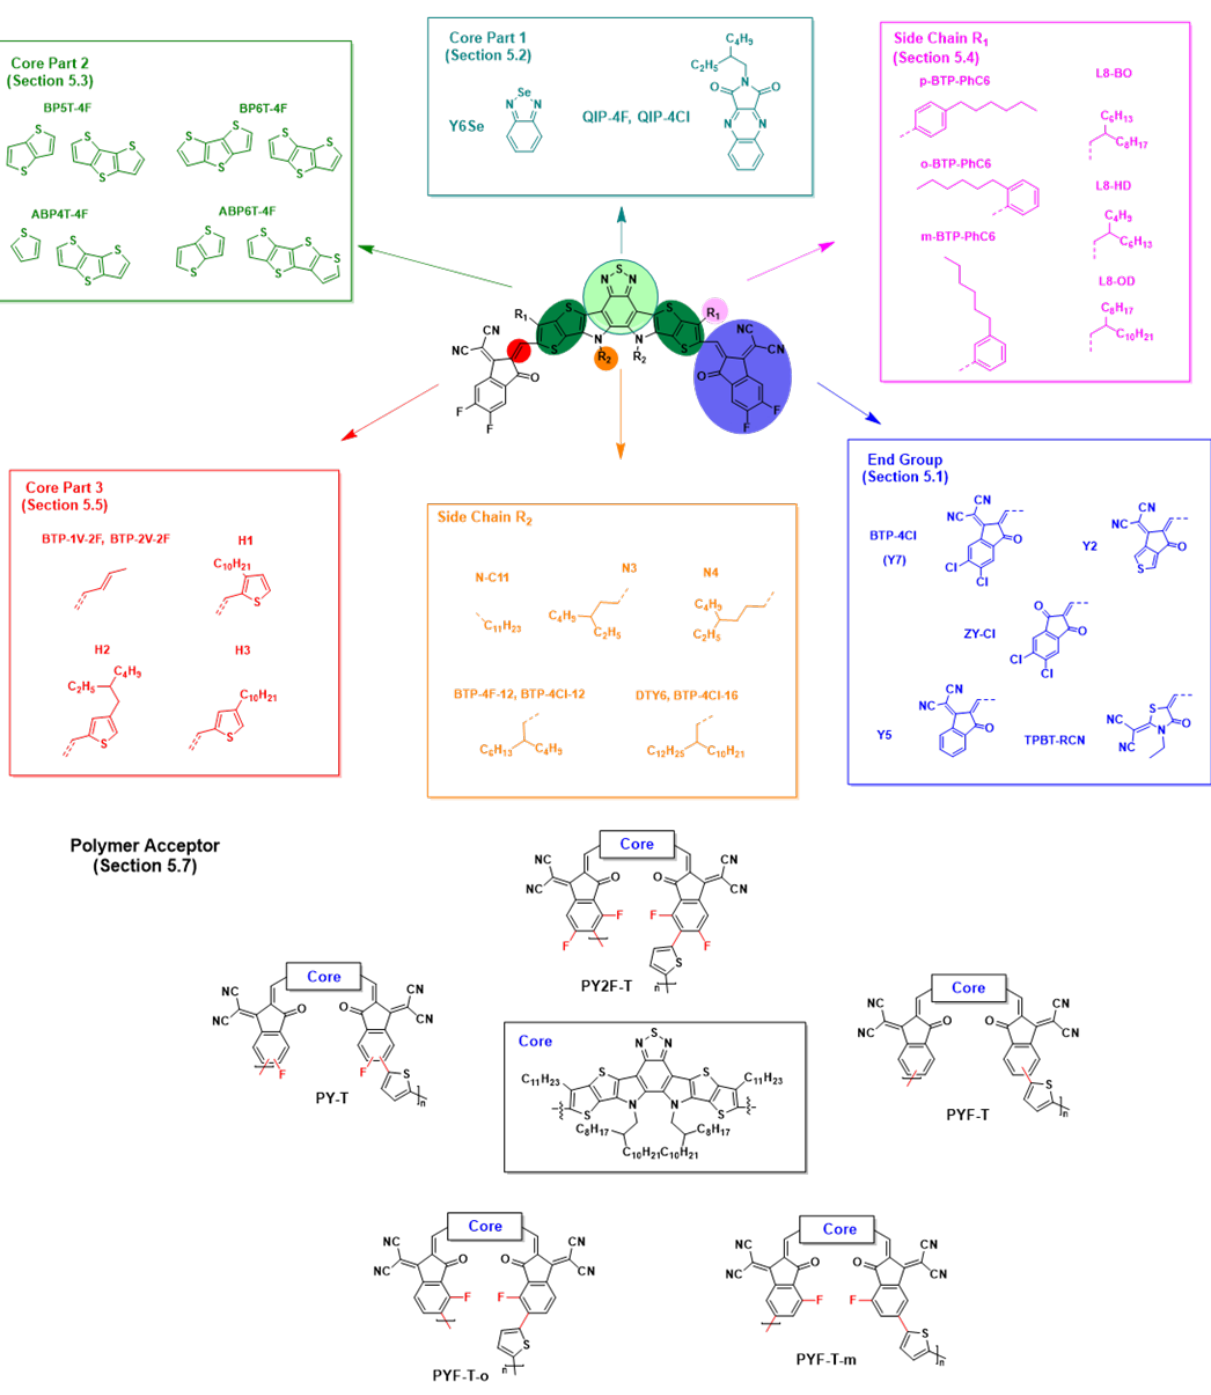
Figure 4. Seven main approaches to alter Y6 to improve efficiency.